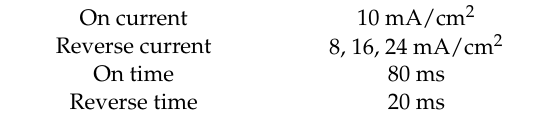
Table 2. On-reverse current condition.